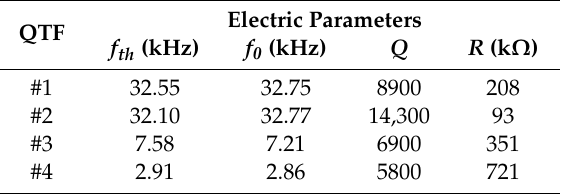
Q-factor value, R : equivalent resistance. f th is the predicted resonance frequency using Equation